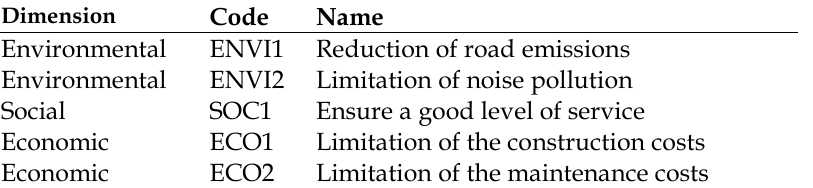
Table 2. Topics related to road sustainability criteria